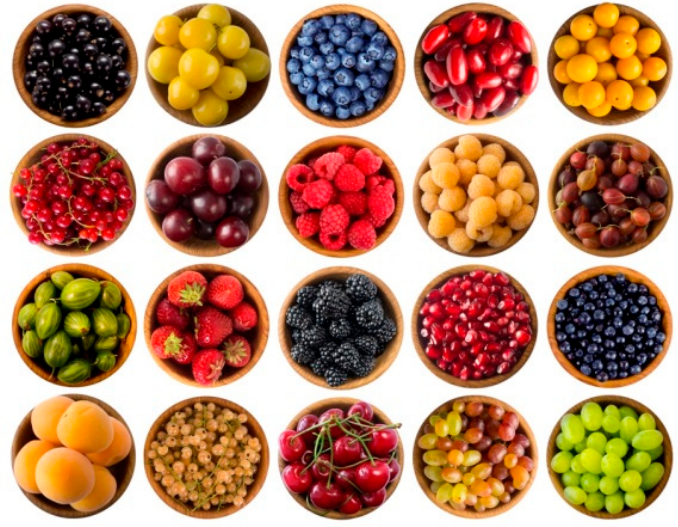
Figure 2. Food rich in the source of anthocyanins.